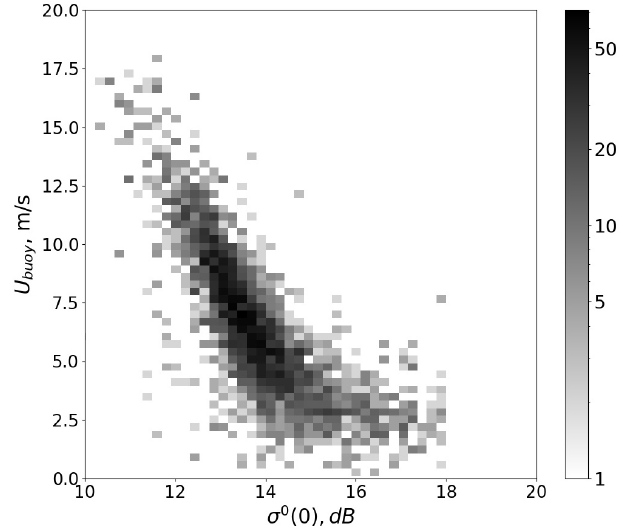
Figure 3. Histogram of wind speed dependence on